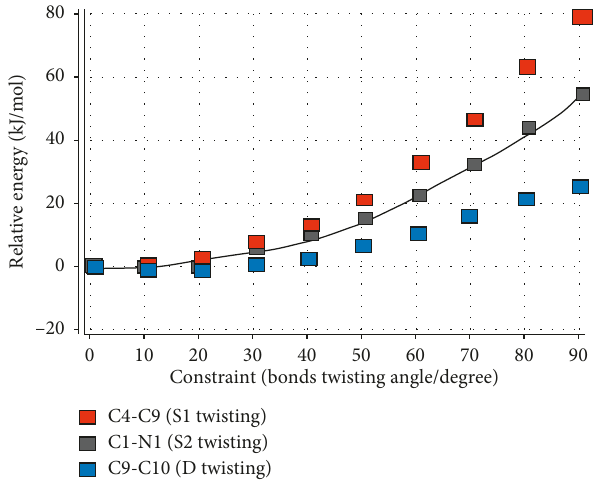
Figure 4: Bond twisting-induced relative energy change in the S state of the BMN